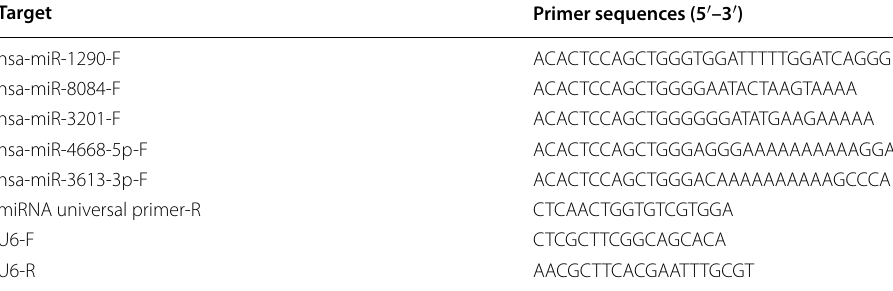
Table 1 Primer sequences Target Primer sequences (5 ′ –3 ′